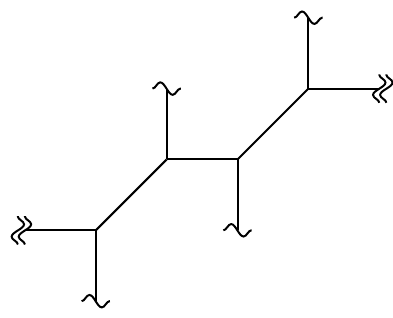
Figure 1 . Network model description of conformal blocks and Nekrasov functions [22, 23]. Dell deformation corresponds to compacti(cid:12)cation in both horizontal and vertical directions, the two elliptic parameters are associated with the two twists [32,